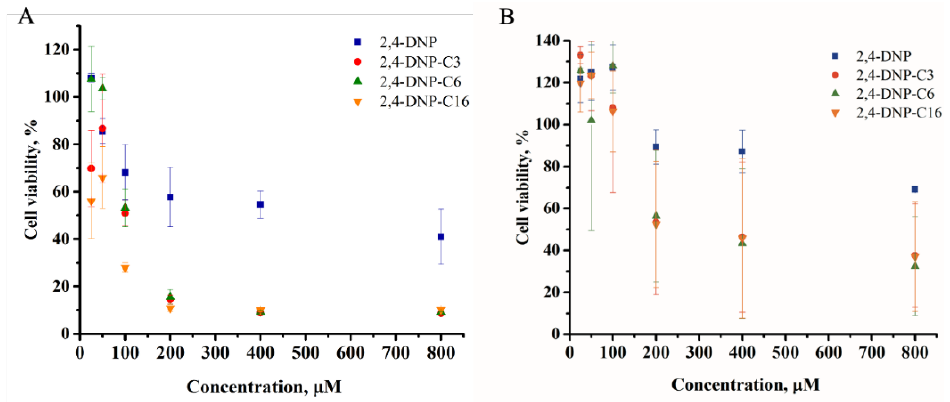
Figure 1. Cytotoxicity of 2,4-DNP (compound 1 ), 2,4-DNP-C16 (compound 2 ), 2,4-DNP-C6 (com- pound 3 ), and 2,4-DNP-C3 (compound 4 ) at concentration range 25-800 µM on ( A ) 4T1-Luc cells after 24 h incubation in RPMI 1640 (10% FBS) and on ( B ) AML12 cells after 24 h incubation in DMEM-F12 (10% FBS) at 37 °C, 5% CO 2 . Untreated cells were set as a control. Samples were dissolved in DMSO. The final concentration of DMSO was 1% per well. Data are presented as mean ± StD ( n = 3 – 5).